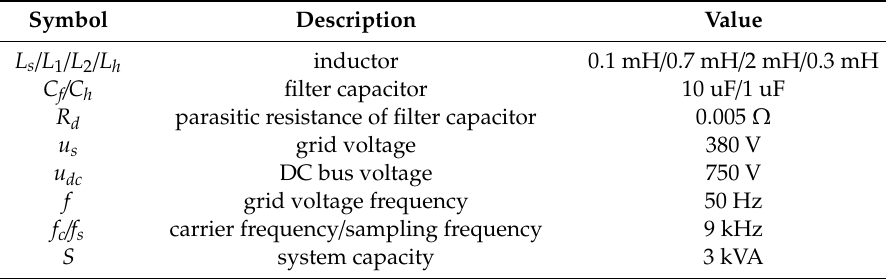
Figure 1. Structure of shunt active power filter (SAPF) system with an LCLCL filter. Table 1. Main parameters of SAPF system.